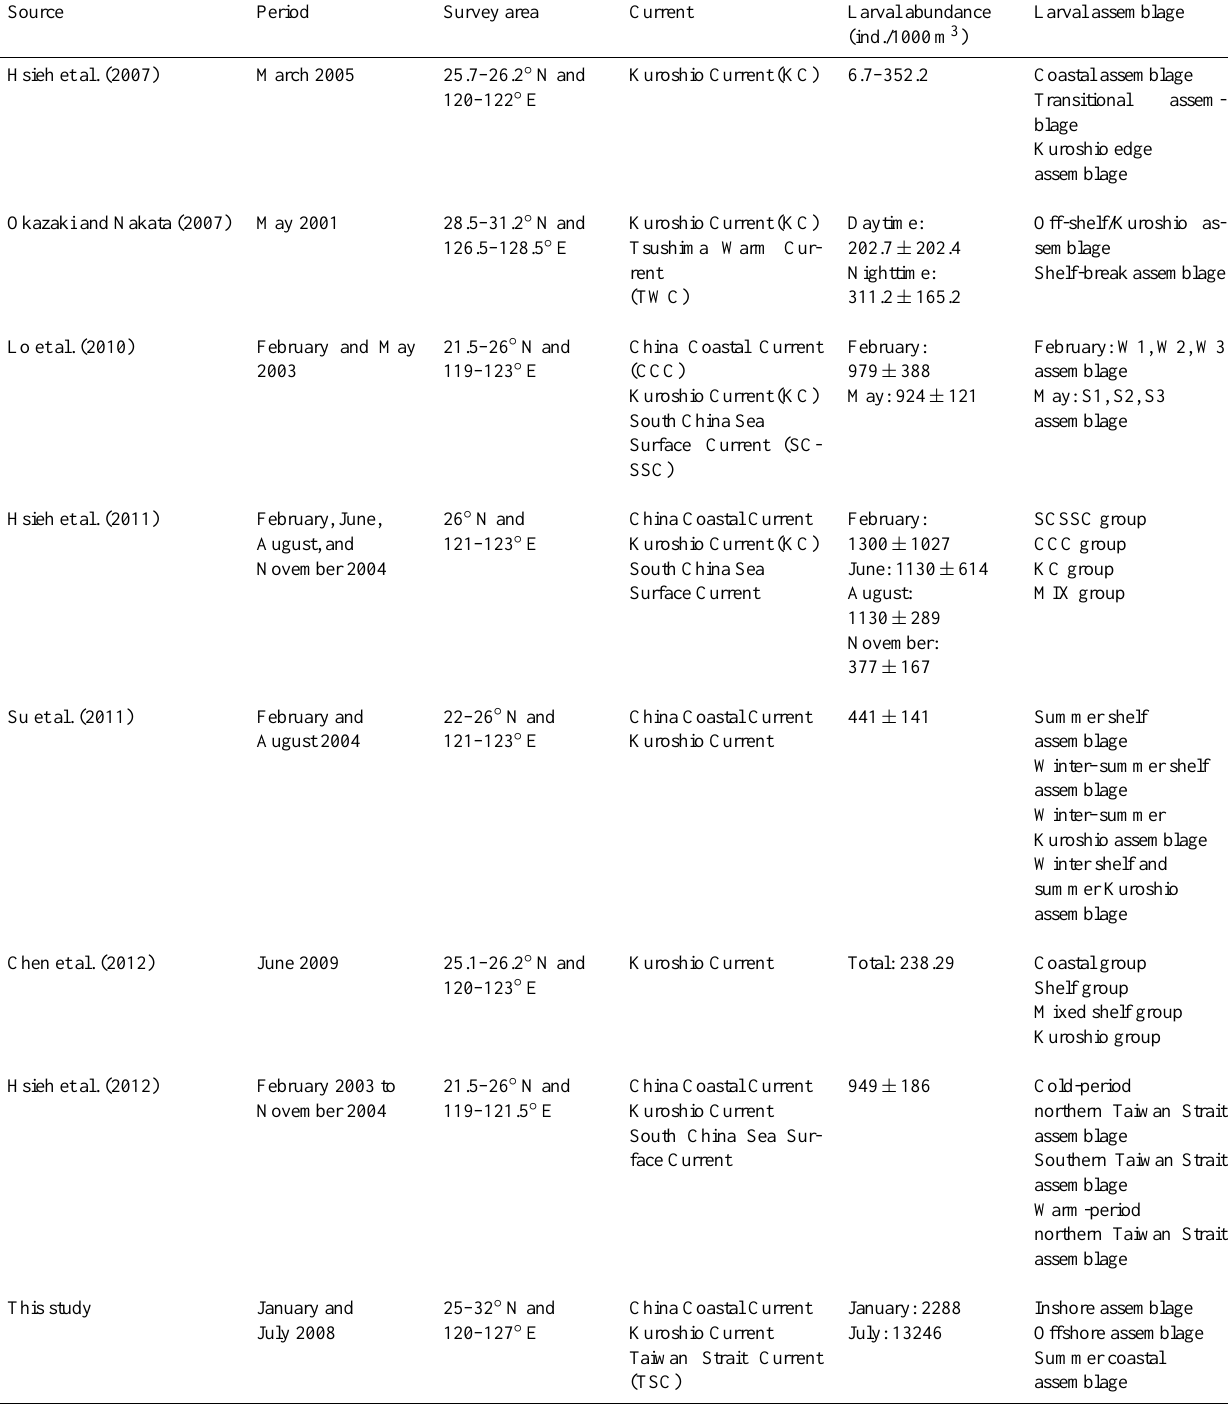
Table 5. Summaries of the several previous studies of larval assemblage together with this survey. Source Period Survey area Larval abundance